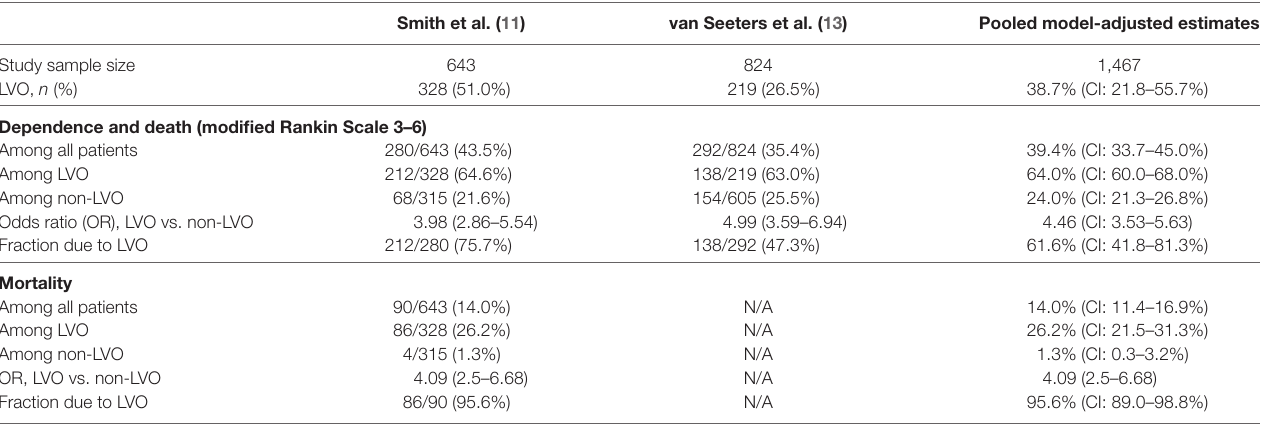
TABLe 2 | Rates and outcomes of large-vessel occlusion (LVO) and non-LVO acute cerebral ischemia. Smith et al. (11) van Seeters et al.